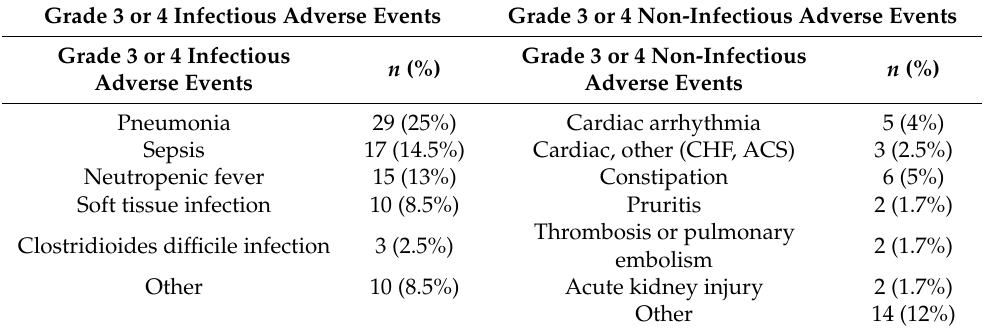
Table 4. Grade 3 or 4 non-hematological adverse events at least possibly related to the study